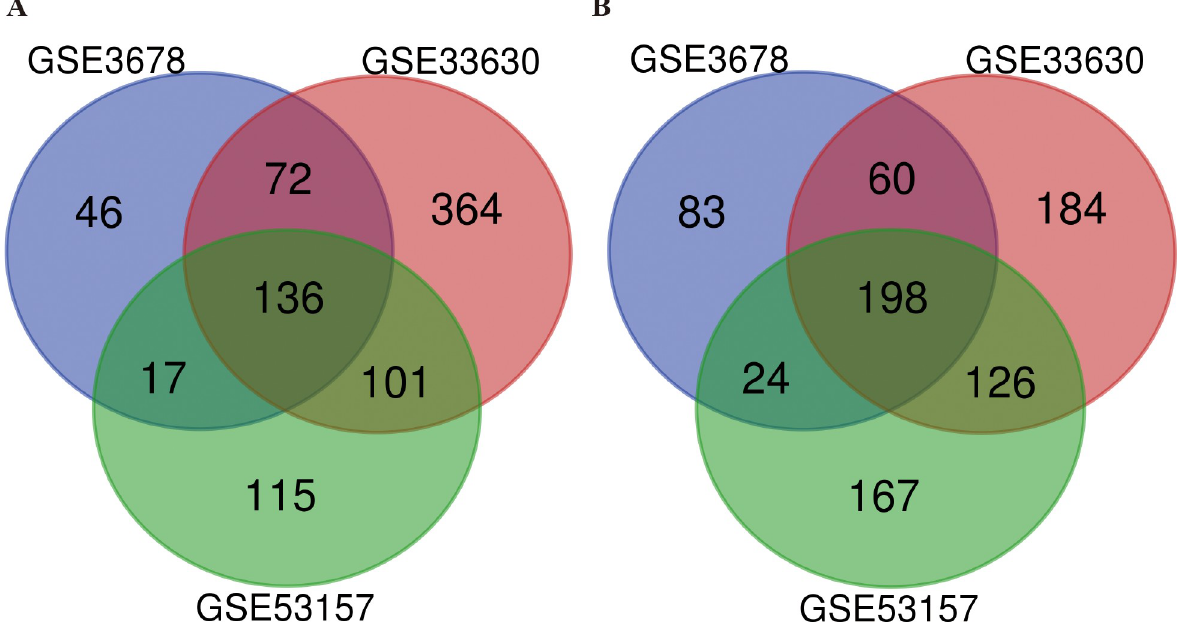
Fig 1. Selection of 334 common DEGs from the three datasets (GSE3678, GSE33630, and GSE53157). A. Venn diagram illustrating 136 upregulated DEGs (logFC � 1); B. Venn diagram illustrating 198 downregulated DEGs (logFC < 1). The number denotes the number of genes shared between/among subtypes or the number of unique